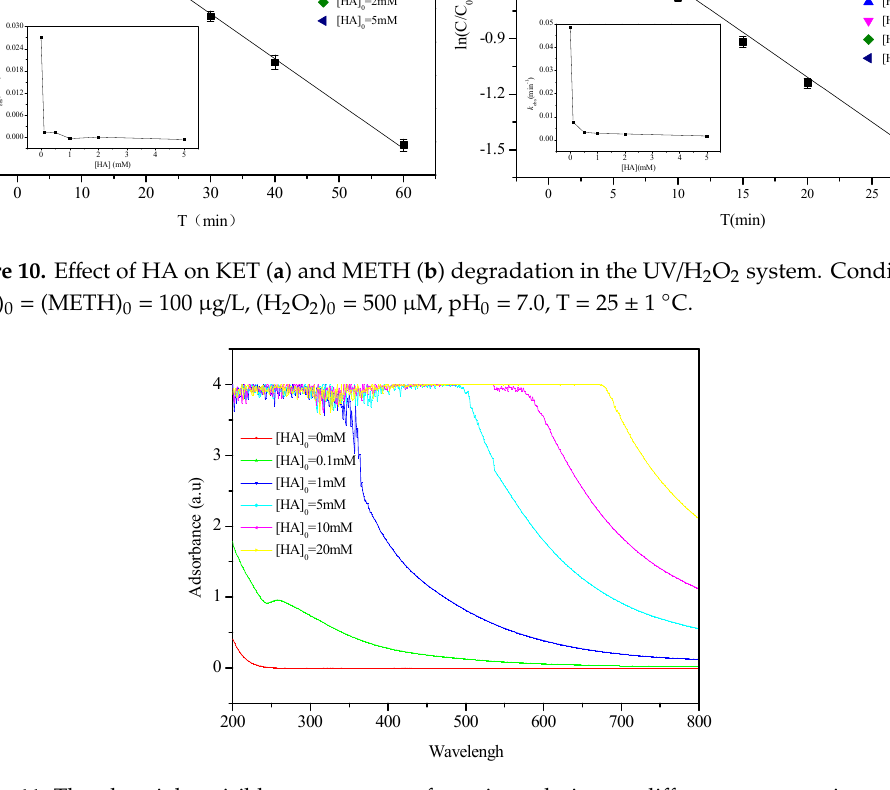
Figure 11. The ultraviolet–visible spectroscopy of reaction solutions at different concentrations of HA.